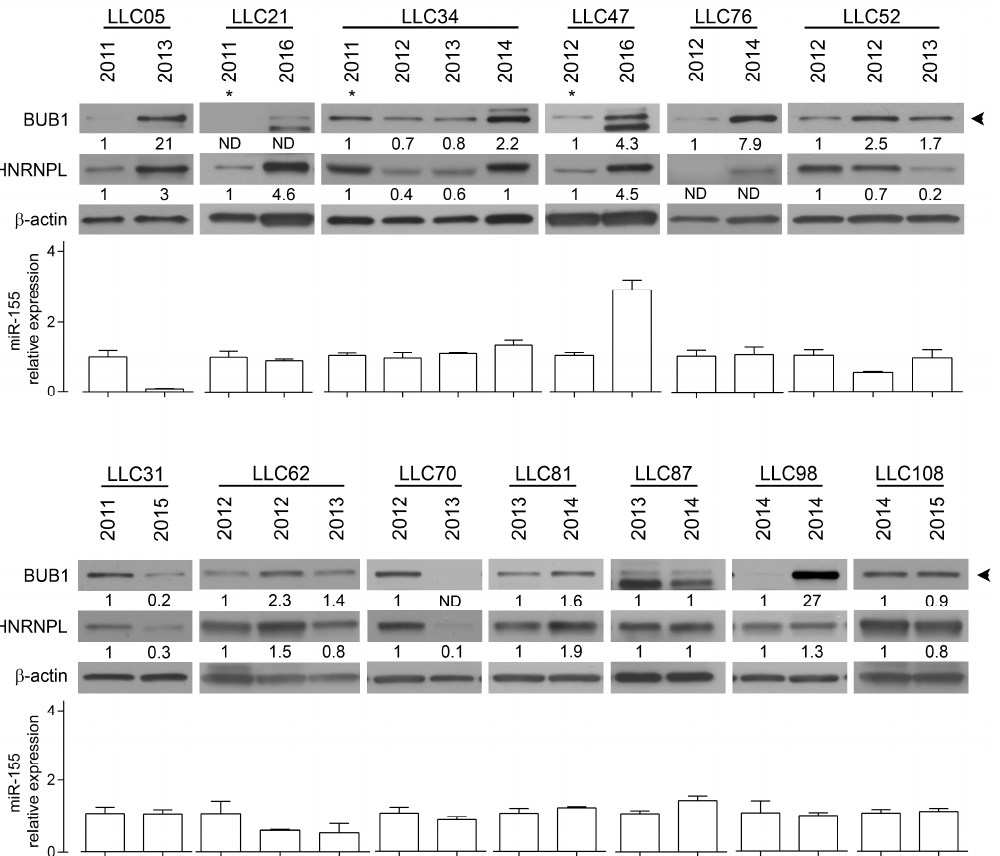
Figure 3. Positive correlation between BUB1 and HNRNPL protein expression in CLL patients. Western blots of BUB1 and HNRNPL proteins and RT-qPCR of miR-155 in longitudinal samples of purified B-CLL cells (LL05, LLC21, LLC34, LLC47, LLC76) and PBMC with > 70% of CD5 / CD19 positive cells (LLC31, LLC52, LLC62, LLC70, LLC81, LLC87, LLC98, LLC108) from CLL patients. Densitometric values normalized to β -actin expression are reported. Asterisks indicate time points with monoclonal B-cell lymphocytosis (MBL). MiR-155 relative expression was normalized to the endogenous reference RNU44 (2 −Δ ct method). Data are means ± SD of three technical replicates.